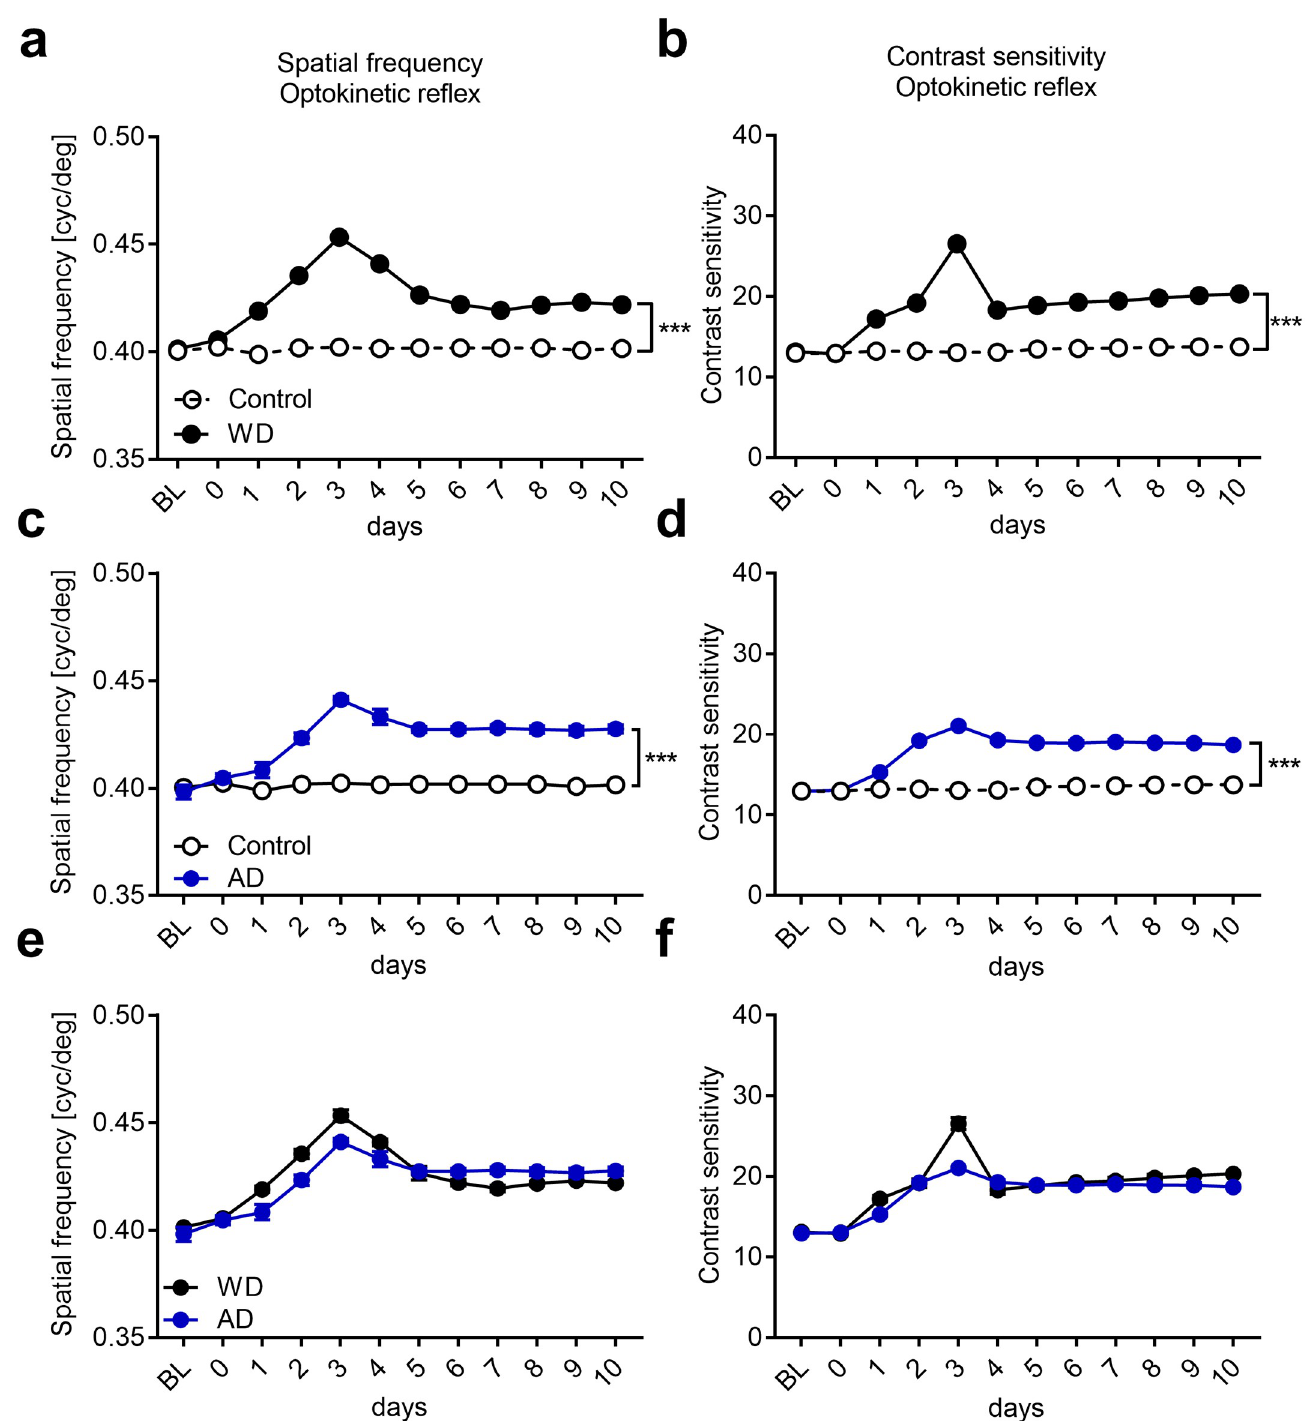
Fig 10. Both WD and AD cross-modally provoke a potentiation of the visual OKR. ( a ) In control mice (n = 4), spatial frequency thresholds did not change over the whole time period tested. However, after WD (n = 4) there was a marked improvement of the spatial frequency sensitivity which reached a peak on day 3. Subsequently, spatial frequency thresholds levels slightly decreased and remained at a stable level above control values until 10 days after WD. ( b ) Contrast sensitivity of the OKR in control mice remained unchanged over 10 days. After WD, contrast thresholds massively improved until day 3. After a slight decrease at 4 days after WD, values then remained at a stable level above control values until 10 days after WD. ( c ) We used values of the same control mice like in Fig 4a. AD (n = 4) led to a marked increase of spatial frequency thresholds peaking at 3 days. Subsequently, spatial frequency sensitivity slightly decreased until day 5 after AD